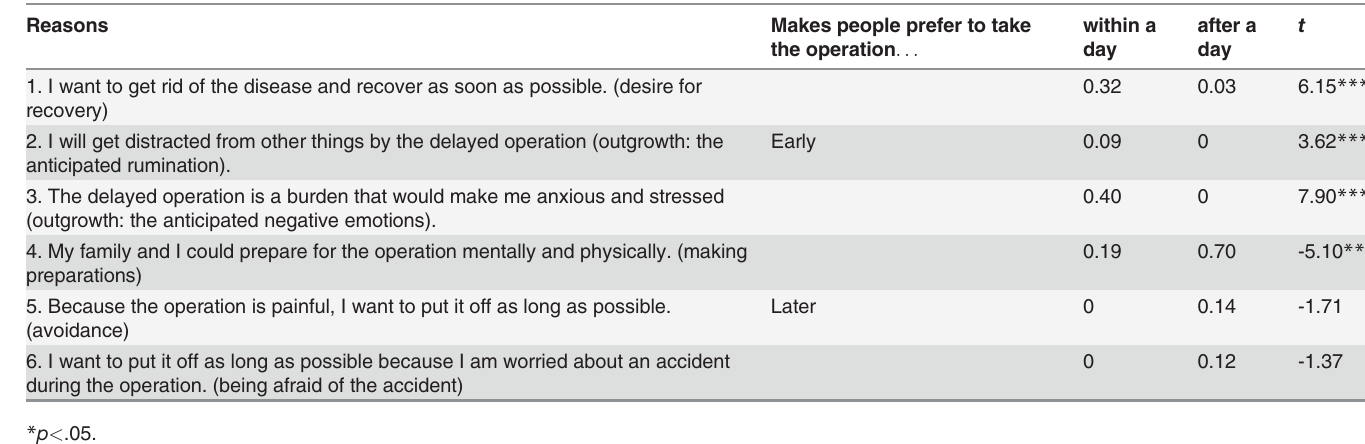
Table 1. The summary and comparison (the two-sample t test) of the proportion of reasons listed by participants who preferred to take the operation within a day and those who preferred to take the operation after a day in Study 1a. Reasons Makes people prefer to take the operation